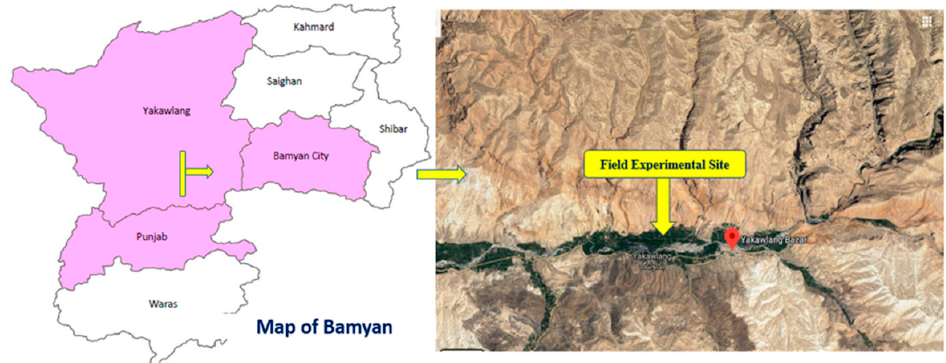
Figure 1. Location of experimental site in Yakawlang district of Bamyan province, Afghanistan.